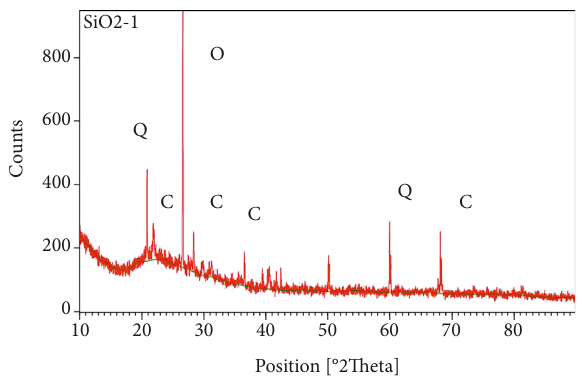
Figure 12: X-ray diffraction pattern of SCBA [78].